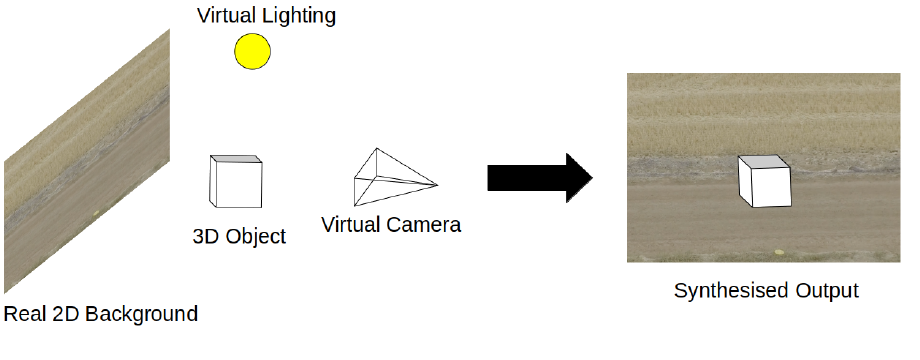
Figure 1. Synthesis via projection of synthetic 3D object onto real 2D